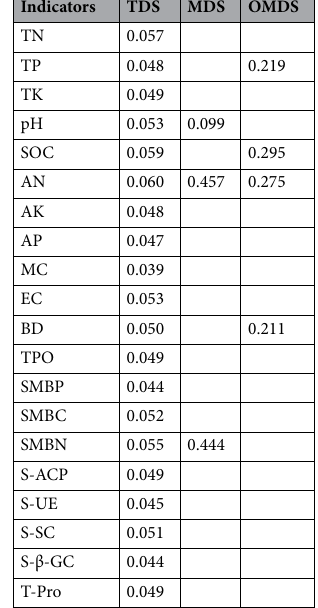
Table 4. Weight values of soil quality indicators in the TDS, MDS, and OMDS.